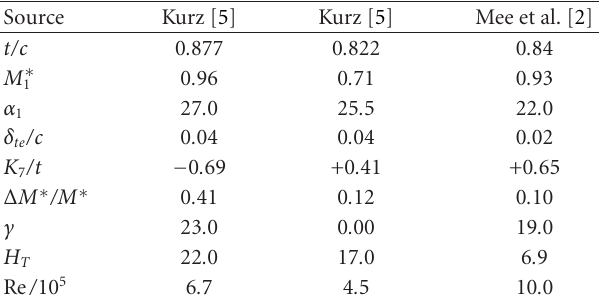
Table 1: Configurations for sample